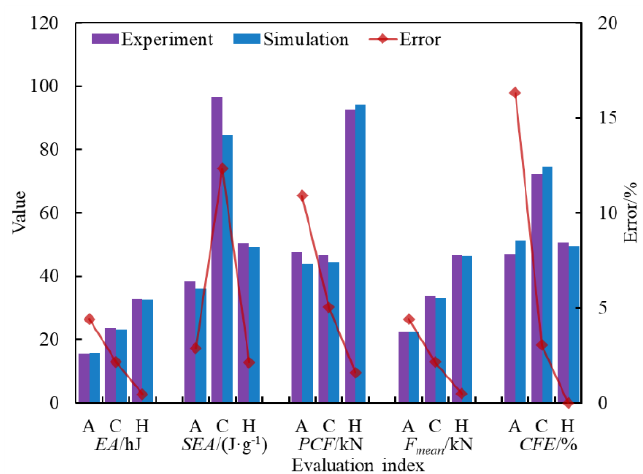
Figure 10. Comparison of evaluation indexes of energy absorption characteristics between the simulation and experiment.